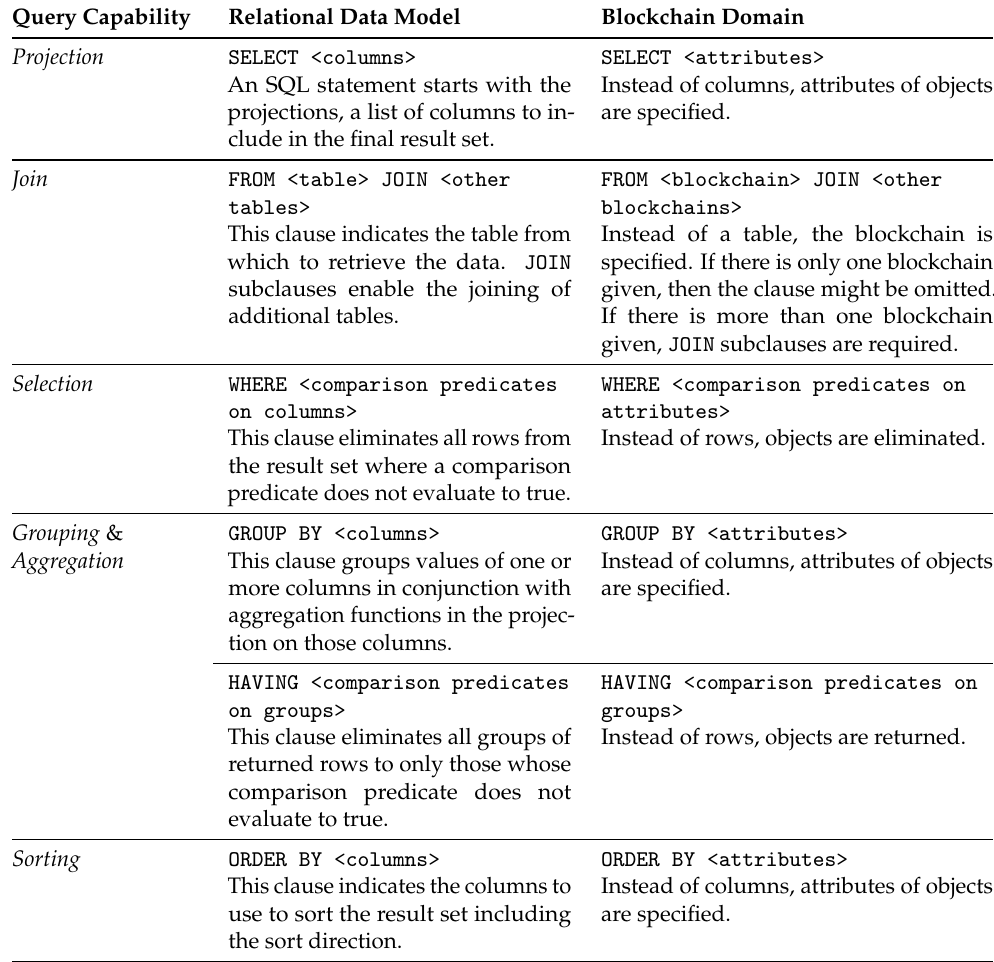
Table 4. The various clauses of an SQL statement and their mapping to the blockchain